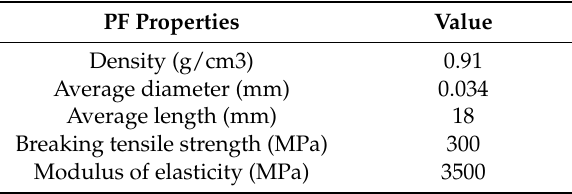
Table 2. Properties of polypropylene fiber.